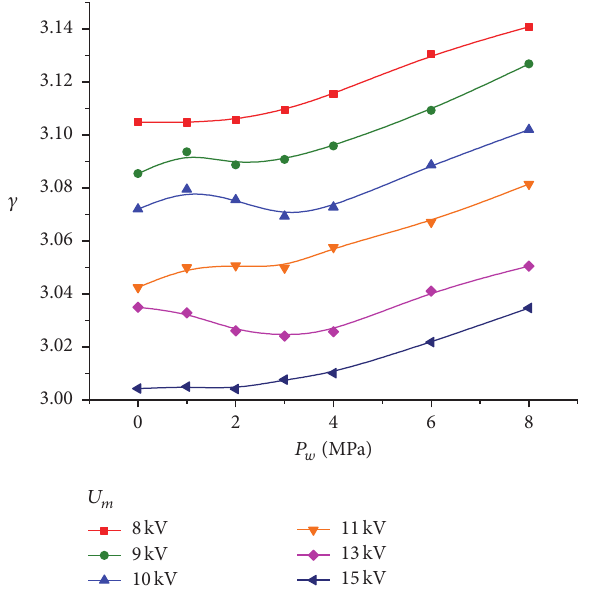
Figure 13: Values of coefficient 𝛾 for different hydrostatic pressures and charging